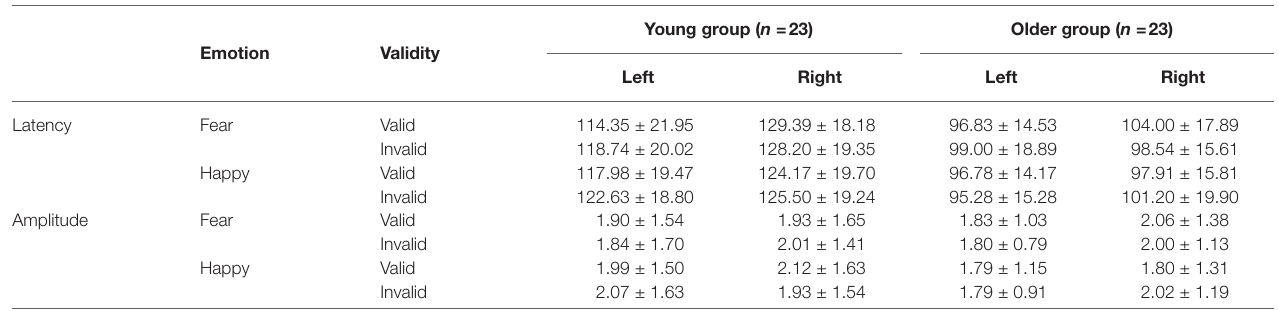
TABLE 3 | Mean latency (ms) and mean amplitude ( μ V) of the P1 ( M ± SD ). Emotion Validity